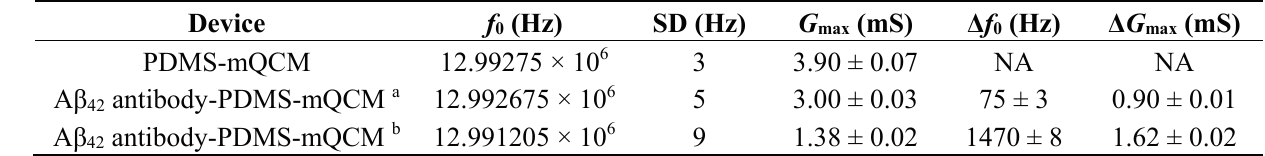
NA: not applicable; a after 150 °C heating treatment; b before heating